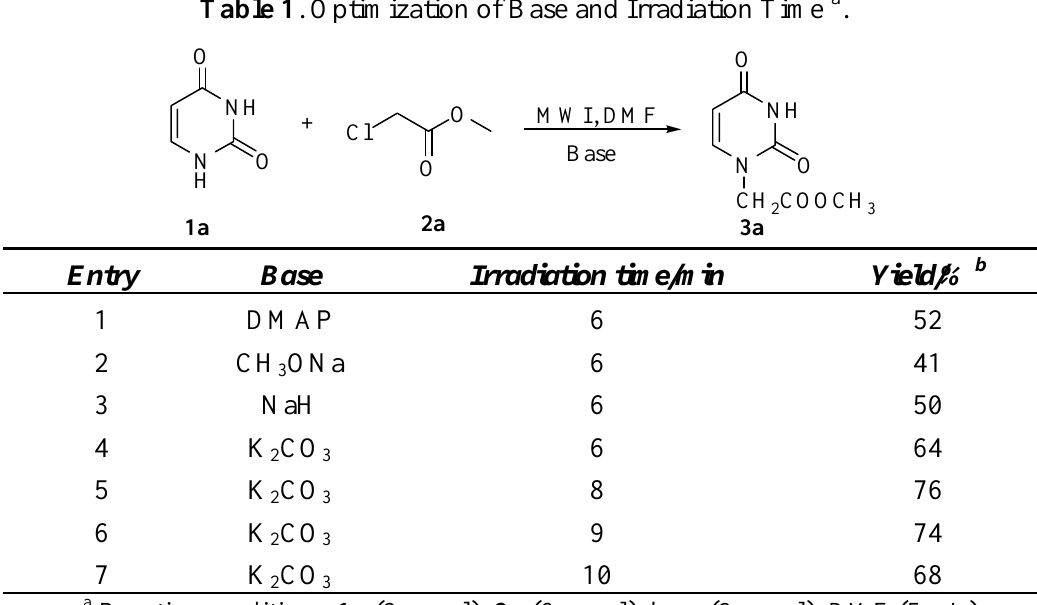
Table 1 . Optimization of Base and Irradiation Time a